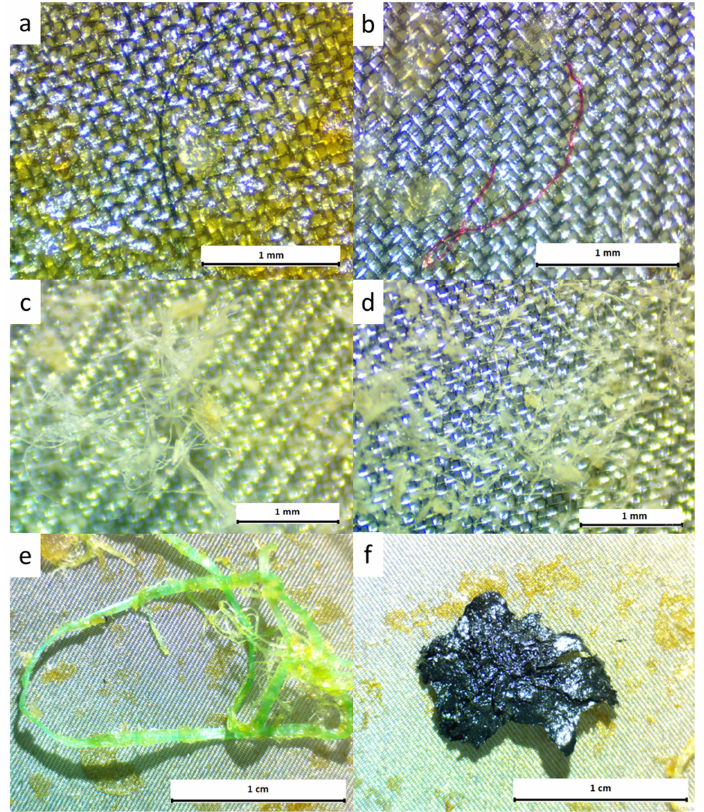
Figure 2. Stereomicroscope photographs of the MPs found in the gastrointestinal tracts of Dicentrar- chus labrax and Sparus aurata analysed in this study; ( a ) blue and ( b ) red microfiber found in the tracts of a Dicentrarchus labrax individual; ( c , d ) tangled messes found in tracts of Sparus aurata; ( e ) line and ( f ) film found in gastrointestinal tract of a Sparus aurata individual . Concerning the colour and size of the microfibers, Figure 3 shows the histogram of the distribution of both parameters. As can be seen, colourless microfibers were the most common (47.7% for Dicentrarchus labrax and 60.9% for Sparus aurata) , followed by blue (35.3% vs. 24.8%, respectively), black (8.7% vs. 7.9%, respectively), and red (4.2% vs. 5.4%, respectively). In the case of Dicentrarchus labrax, yellow microfibers (2.5%), grey (0.8%), green (0.4%), and violet (0.4%) were also found, while white (0.5%) and pink (0.5%) mi- crofibers were found in Sparus aurata . The size of the microfibers ranged between 50 µm and 12.4 mm, with those of 0.8–1.2 mm being the most abundant. Data show a similar MP shape, colour, and length pattern for both species, which may be related to exposure to the very homogeneous environmental conditions that occur in such fish farms.